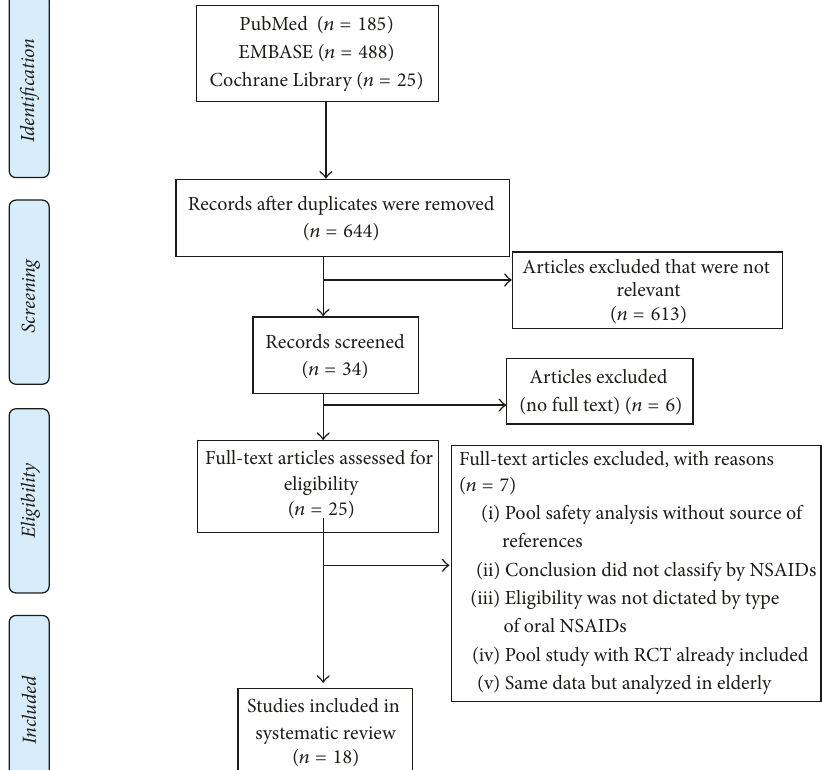
Figure 1: The flowchart of the selected studies in this systematic